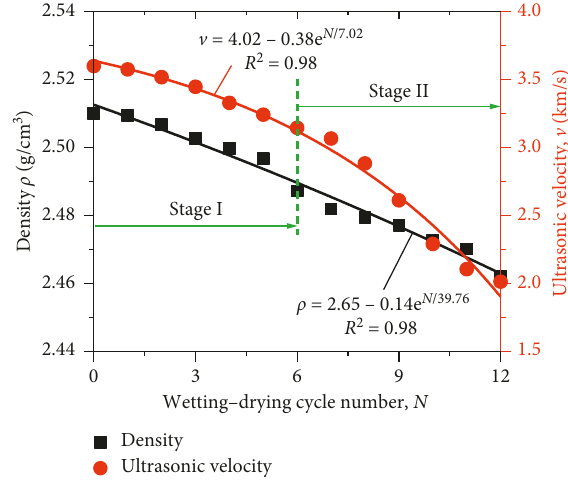
Figure 6: Variations in density and ultrasonic velocity with dif- ferent wetting-drying cycle